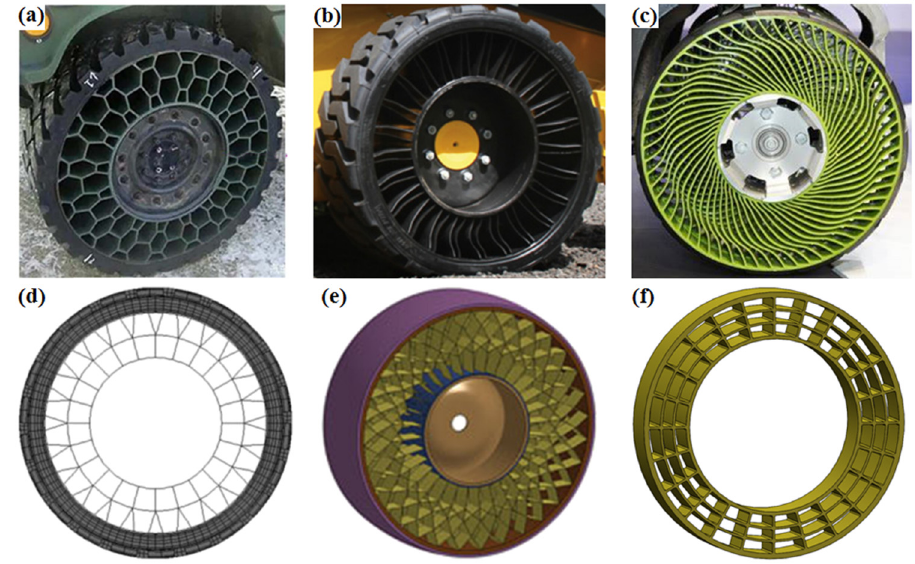
Figure 1: Nonpneumatic tires. ( a ) Honeycomb tire [ 6 ] ; ( b ) Tweel tire [ 25 ] ; ( c ) AC tire [ 26 ] ; ( d ) interconnected mesh tire [ 10 ] ; ( e ) Kucwheel [ 22 ] ; and ( f ) grid type tire [ 24 ]